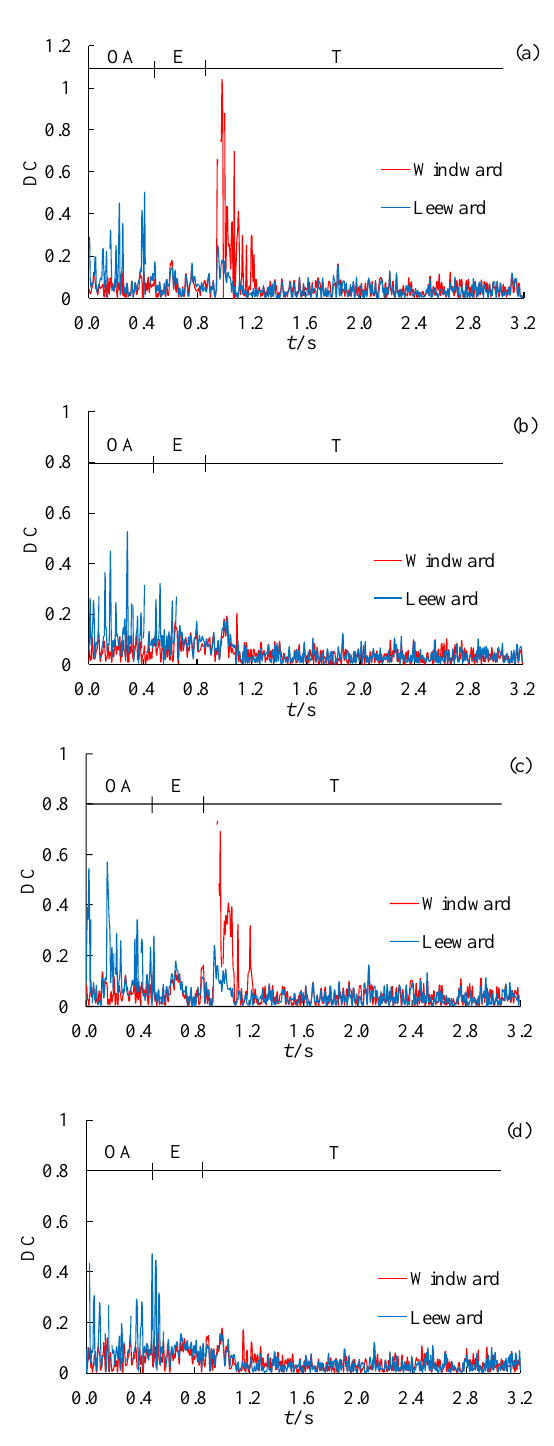
Figure 17. Time-history of head carriage derailment coefficient (DC) conditioned train speed 250 km/h, crosswind velocity 15 m/s, ( a ) 1st wheelset, ( b ) 2nd wheelset, ( c ) 3rd wheelset, ( d ) 4th wheelset (open air (OA); entering entrance (E); tunnel (T)).